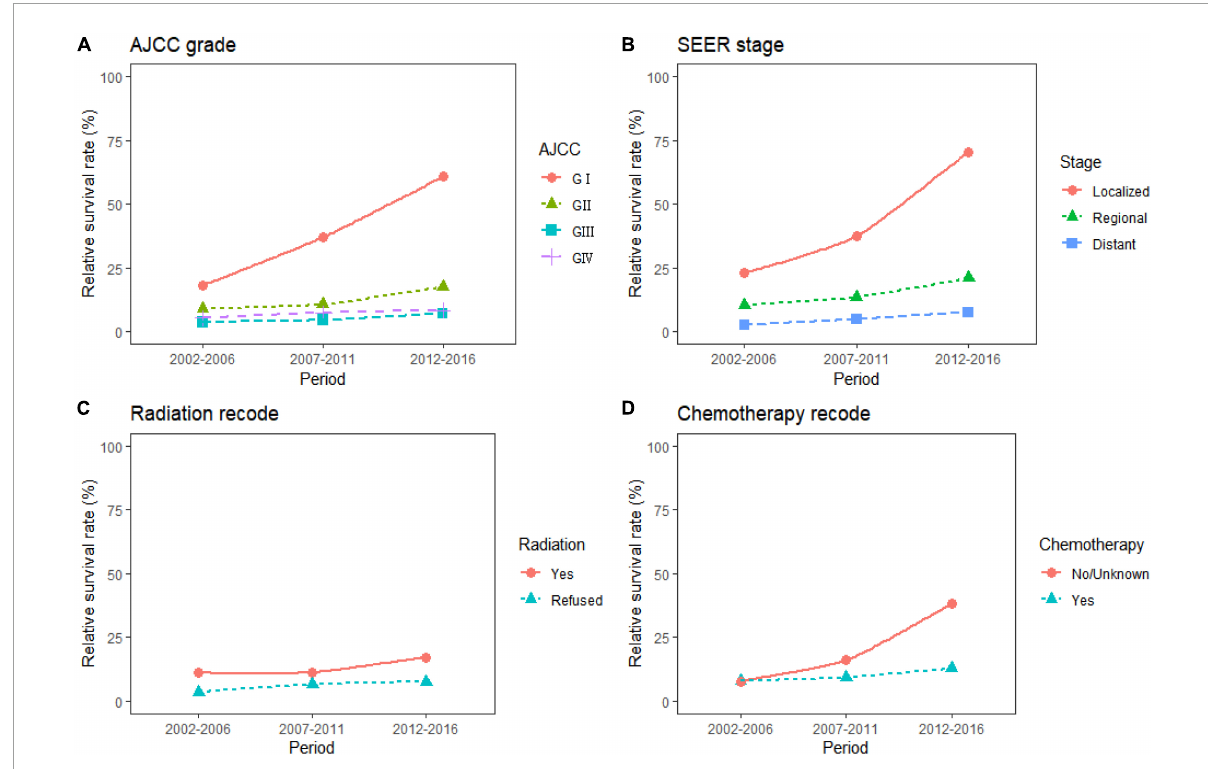
FIGURE4 Five-year relative survival rates according to differentiation grade ( A , GI, GII, GIII, and GIV), SEER stage ( B , localized, regional, distant), radiation therapy ( C , yes, refused), and chemotherapy ( D , yes, no/unknown) for patients with pancreatic cancer (PC) from 2002 to